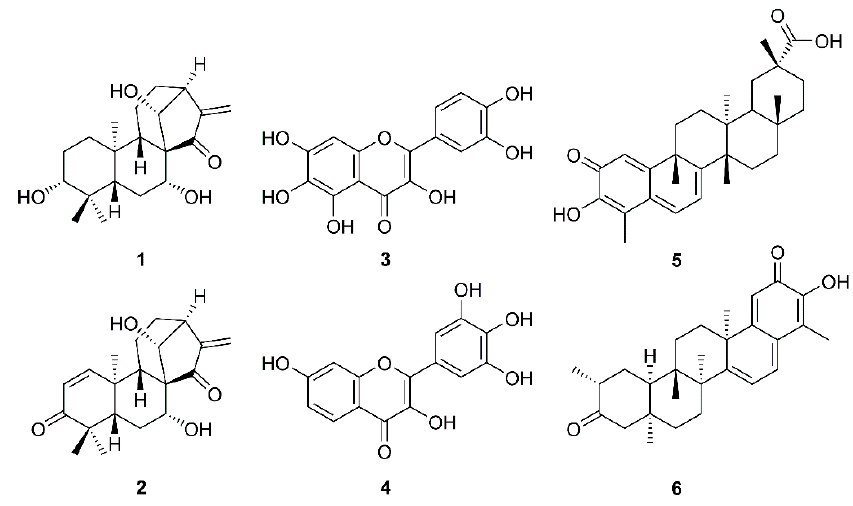
Figure 2. Some natural products patented as anti-SARS-CoV agents from